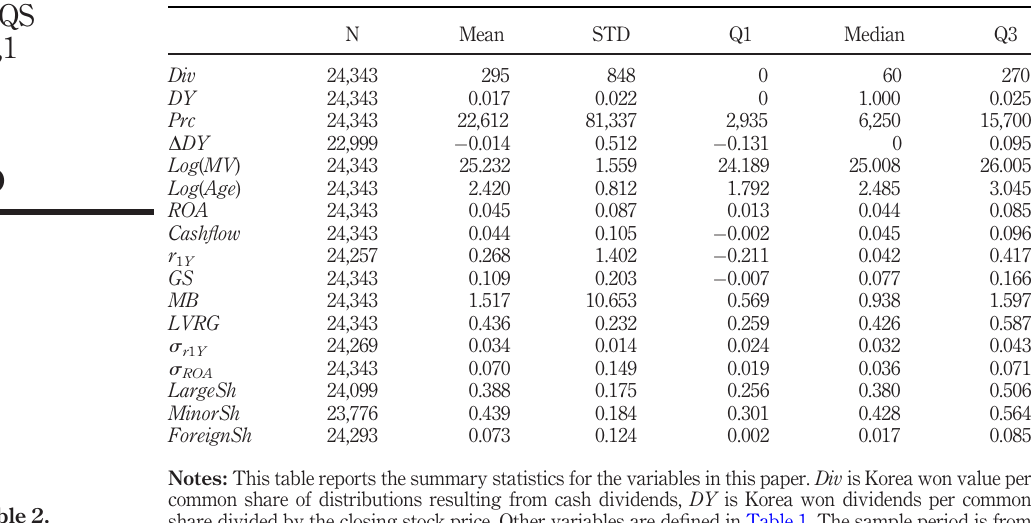
Table 2. Summary